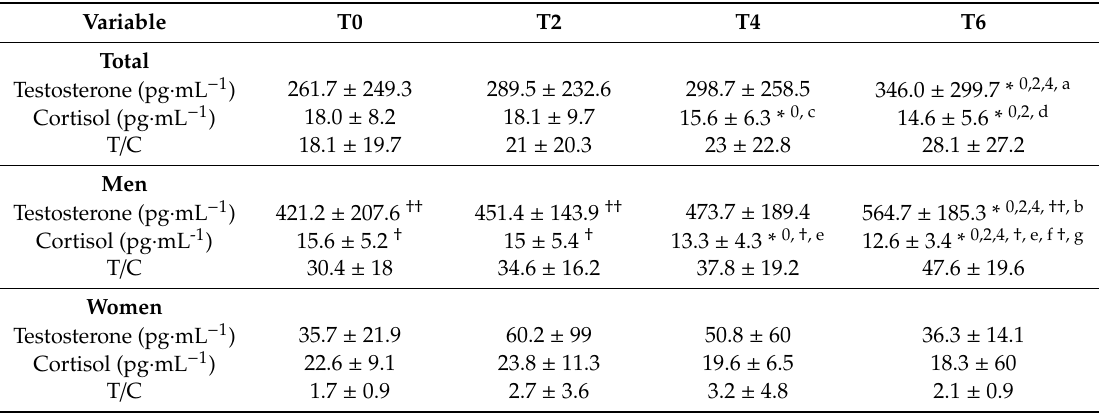
Table 3. Mean ± standard deviation of testosterone (T) and cortisol (C) levels and the ratio of testosterone to cortisol (T / C) at di ff erent measurement times in men and